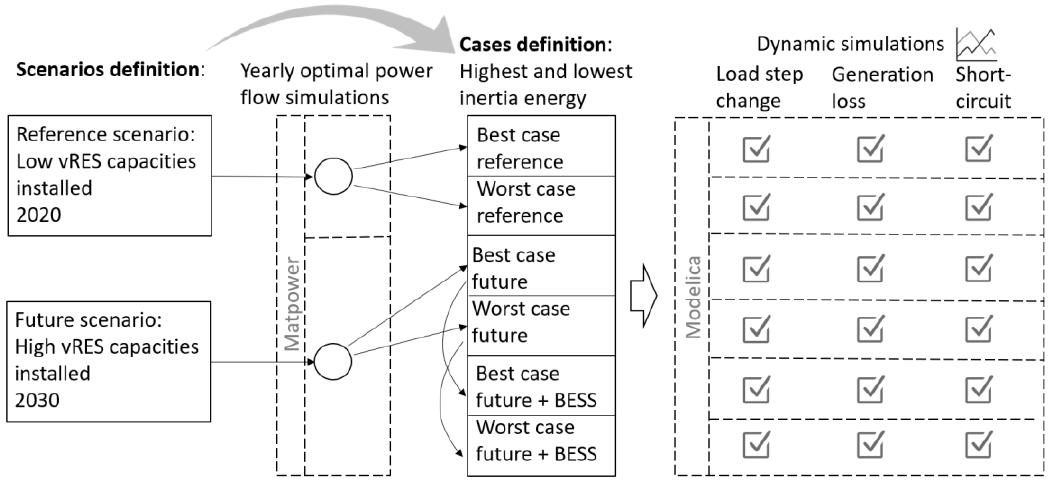
Figure 3. Illustration of the following methodology.